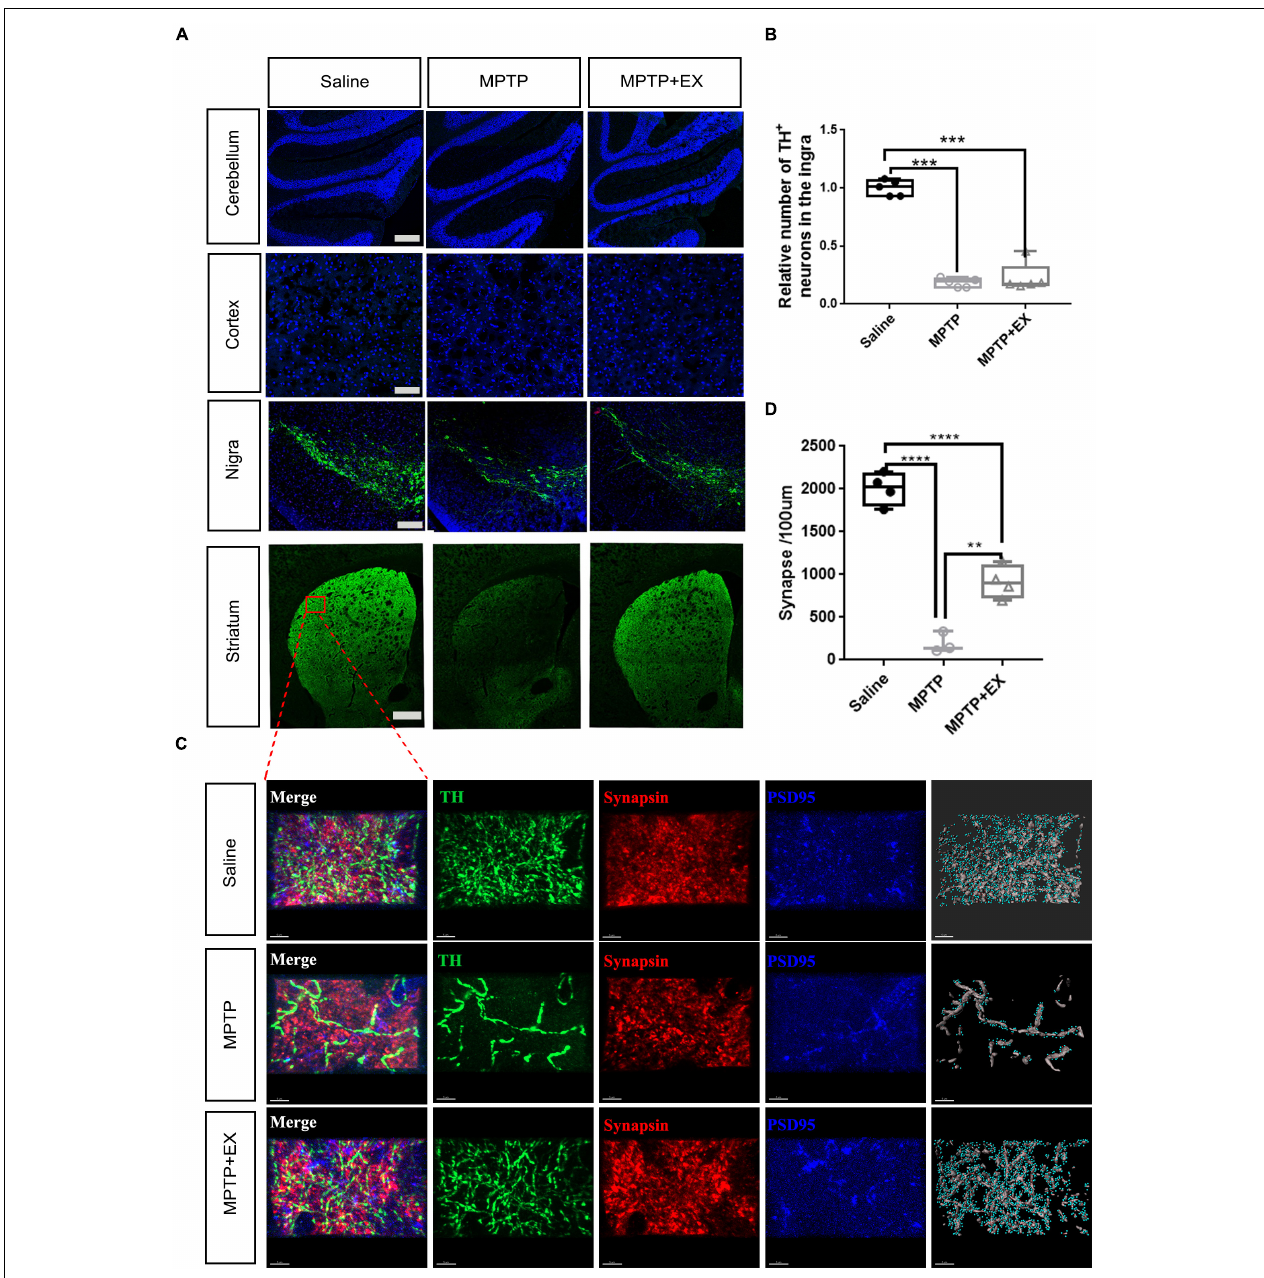
FIGURE 5 | Immunohistochemical staining experiments validate synaptogenesis involved in exercise-induced PD recovery. (A) TH + staining in the cerebellum (scale bar, 200 µ m), cortex (scale bar, 200 µ m), SN (scale bar, 200 µ m), and striatum (scale bar, 500 µ m). (B) Relative number of TH + cells in the SN for Saline, MPTP, and MPTP + EX groups ( n = 5 per group). (C) Immunohistochemical staining of TH + fibers (green) stained with synaptic markers in striatum (scale bar, 5 µ m). Presynaptic terminals and postsynaptic structures were stained by synapsin (Syn, red) and postsynaptic density protein 95 (PSD95, blue), respectively. Synapses were identified by the close proximity of pre- and postsynaptic elements ( < 1 µ m). A 3D construction of PSD-95 and presynaptic synapsin was performed with “create spots” algorithm in Imaris (scale bar, 5 µ m). (D) Quantitation of synapses in the striatum for saline, MPTP, and MPTP + EX groups ( n = 3–5 per group).